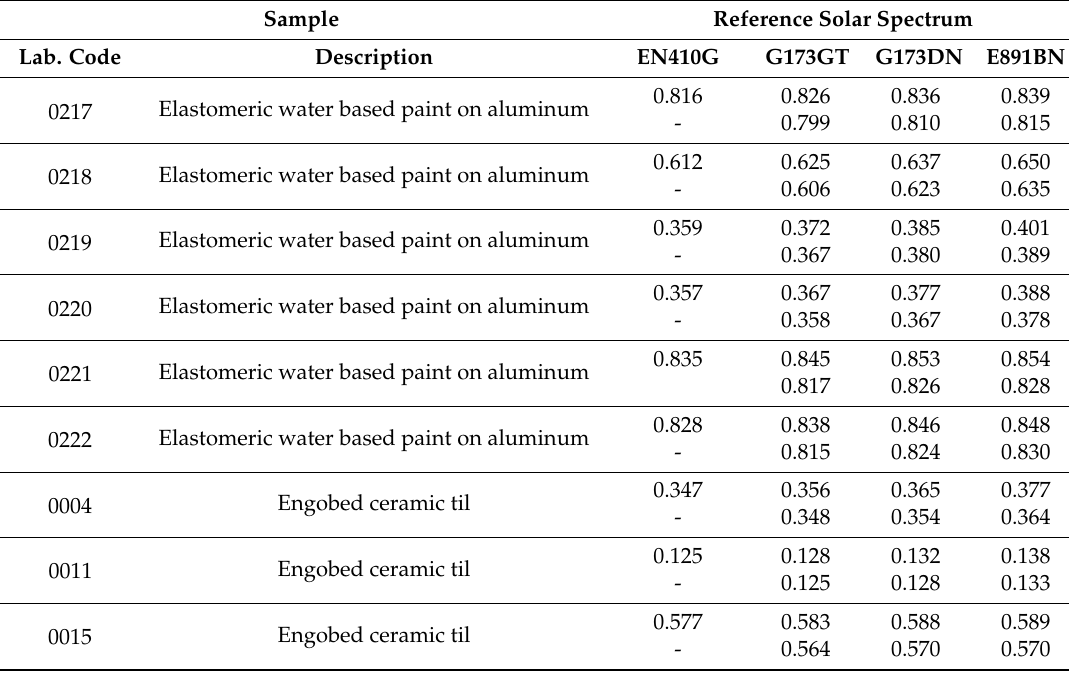
Table 2. Measured solar reflectance